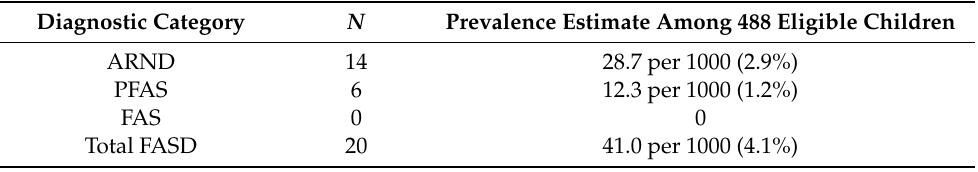
Table 3. FASD Diagnostic